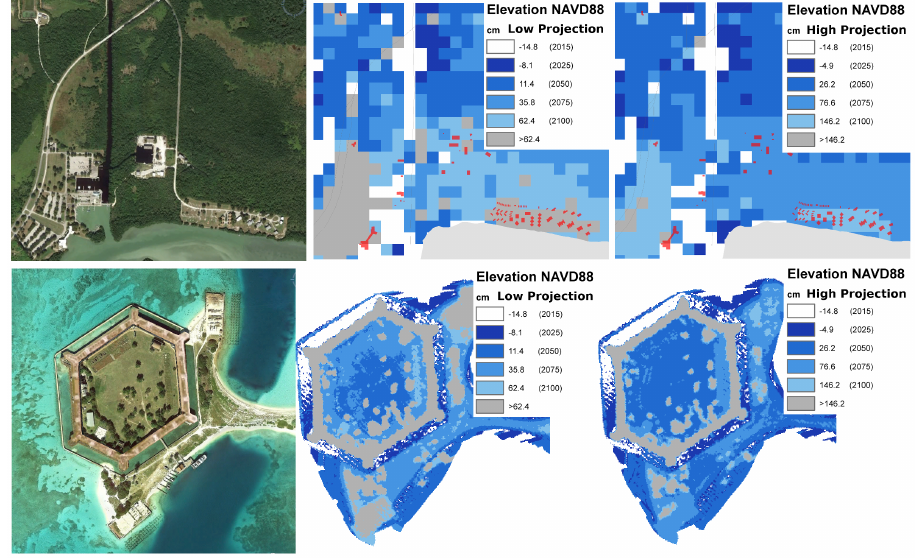
Figure 9. Sea level rise inundation maps at Flamingo in Everglades National Park ( top row ) and Fort Jefferson in Dry Tortugas National Park ( bottom row ). Building and infrastructure footprints are indicated in